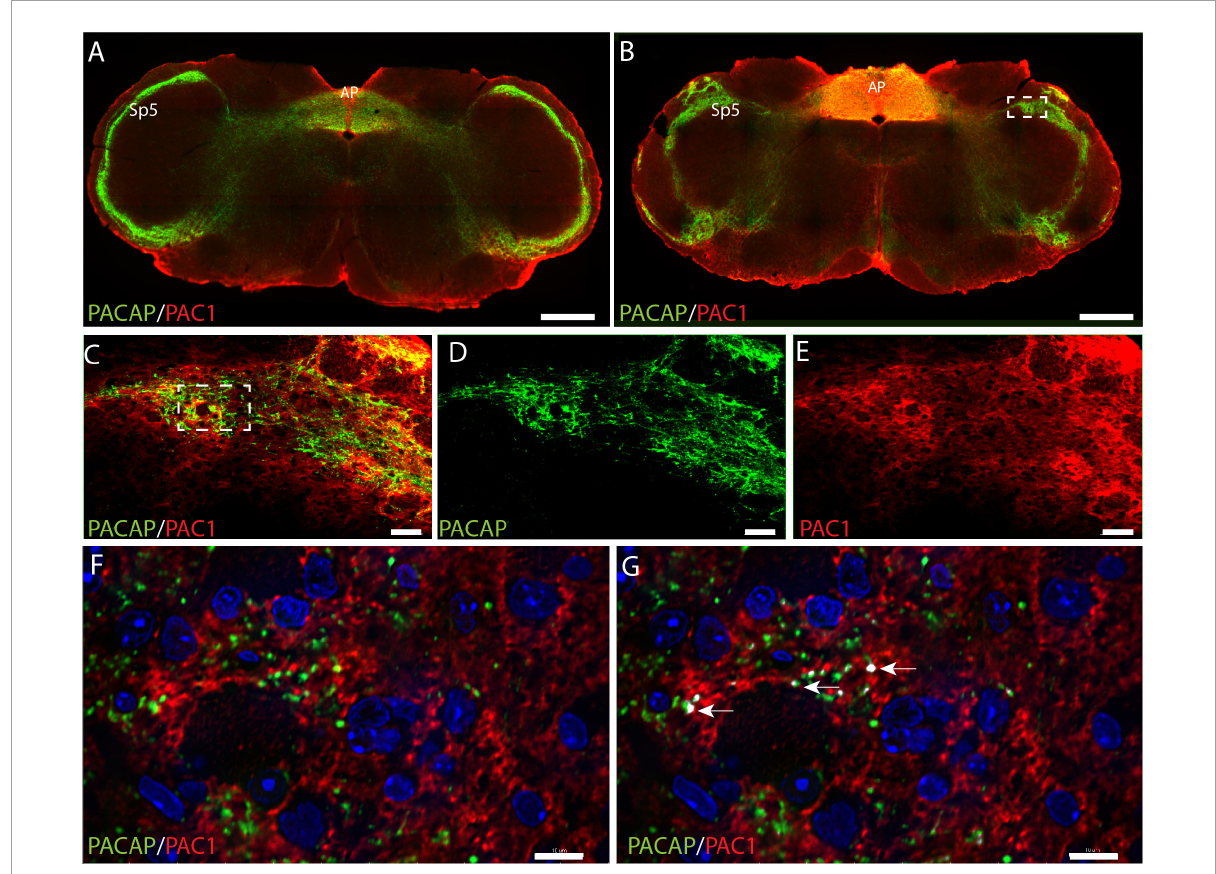
FIGURE5 Distribution of PACAP (green) and PAC1 (red) at two levels of the brain stem at the level of the spinal trigeminal nucleus (SP5) and area postrema (AP). An overview of the brain stem in two different levels is presented in panels (A,B) . The dashed box in panel (B) is magnified in panels (C–E) with double immunostaining in panel (C) , PACAP (D) , and PAC1 (E) . The dashed box in panel (C) is further magnified in panels (F,G) showing PAC1 immunoreactivity near PACAP nerve terminals. The arrows in panel (G) represent close appositions (colocalization) visualized with IMARIS colocalization module, most likely representing synaptic appositions. Scale bars (A,B) = 500 µ m, (C–E) = 50 µ m, (F,G) = 10 µ